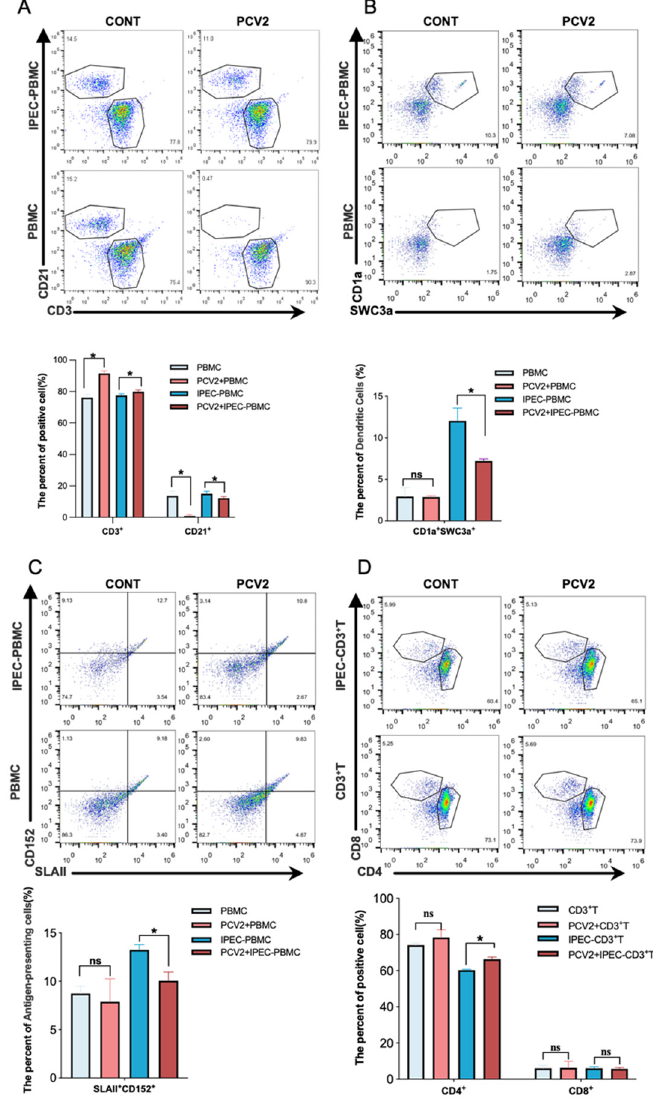
Figure 1. The changes in the frequency of immune cells caused by PCV2-infected IPEC-J2. On the bottom chambers of the transwell system, IPEC-J2 cells were seeded and then infected with PCV2 (MOI = 1) for 48 h. In the upper chambers, fresh PBMCs were added. Flow cytometry was used to determine the frequencies of total T cells, B cells ( A ), DCs ( B ) and APCs ( C ) in the upper chambers after 3 days of co-culture. PBMCs were also individually cultured or infected with PCV2 directly for 48 h as a control. Using CD3 MicroBeads, total T cells were collected and co-cultured with IPEC-J2 or IPEC-J2 infected with PCV2. After 3 days of co-culture, the frequencies of CD4 + T cells and CD8 + T cells were determined by flow cytometry ( D ). All assays were performed in triplicate, with three technical repeats for each sample. * p <